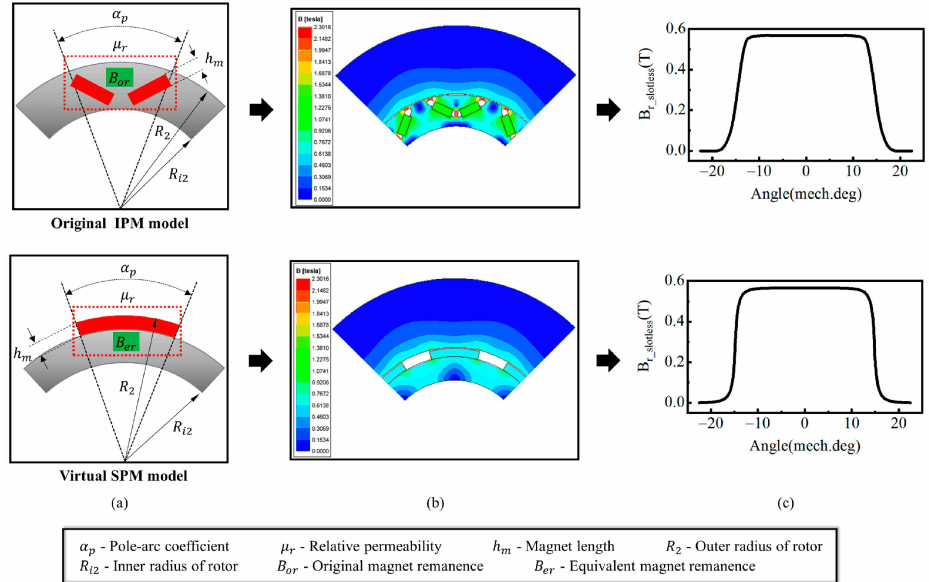
Figure 5. Comparison between original IPM and its equivalent virtual SPM: ( a ) Rotor cross section comparison. ( b ) Equivalent flux density distribution. ( c ) Slotless radial air-gap flux density